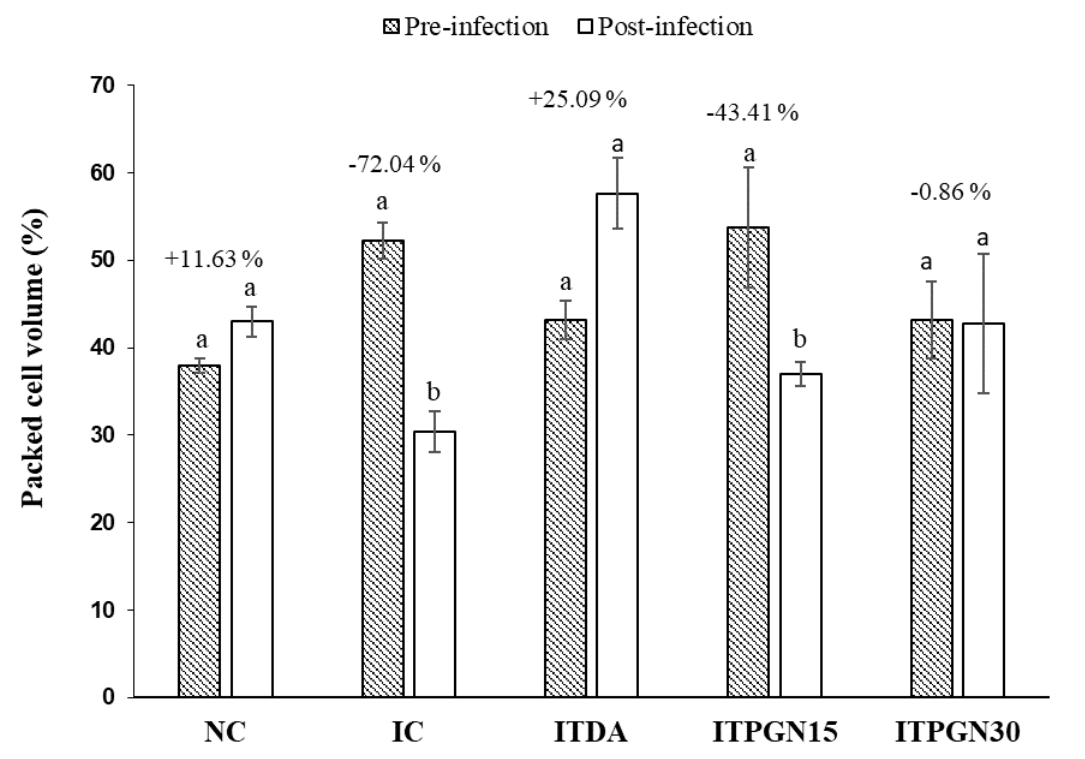
Figure 4. Assessment of anemia progression in T. congolense -infected rats treated with different doses of phloroglucinol. All data are presented as mean ± standard deviation of seven rats. Data was analyzed using paired sample t. test within group. Bars with different alphabets are considered statistically significant at p < 0.05. NC = Normal control, IC = Infected control, ITPGN15 = Infected +